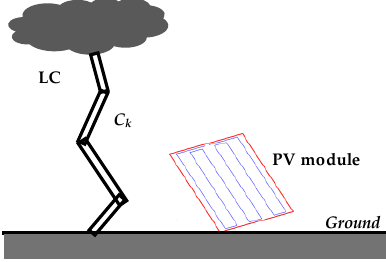
Figure 1. Geometrical model of the tortuous lightning channel (LC).